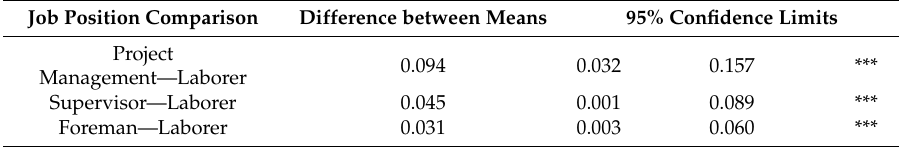
Table 4. t Tests: Least Significant Difference (LSD) for Safety Climate Score (SCS) and job position.